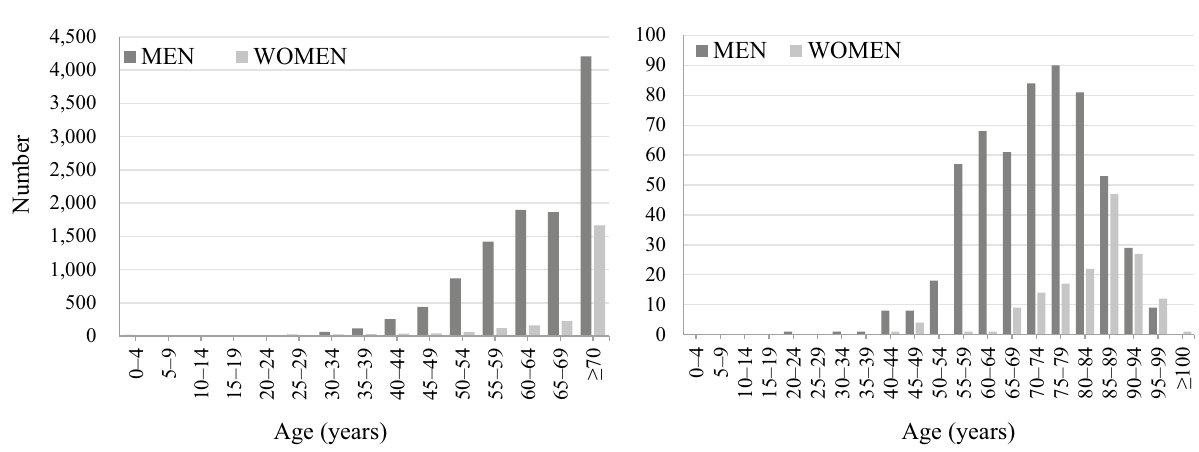
Figure 2. Age-sex distribution of the incidence (a) and number of fatal cases (b) of legionellosis in Japan, 1999–2017.